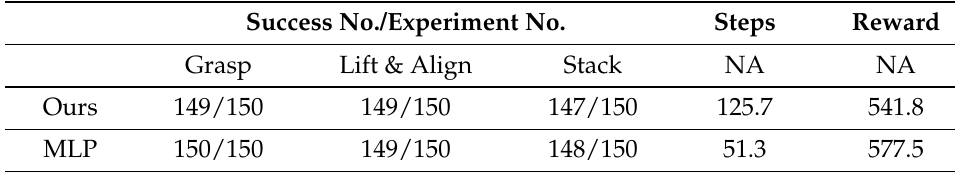
Table 1. Comparison between our method and the MLP-based